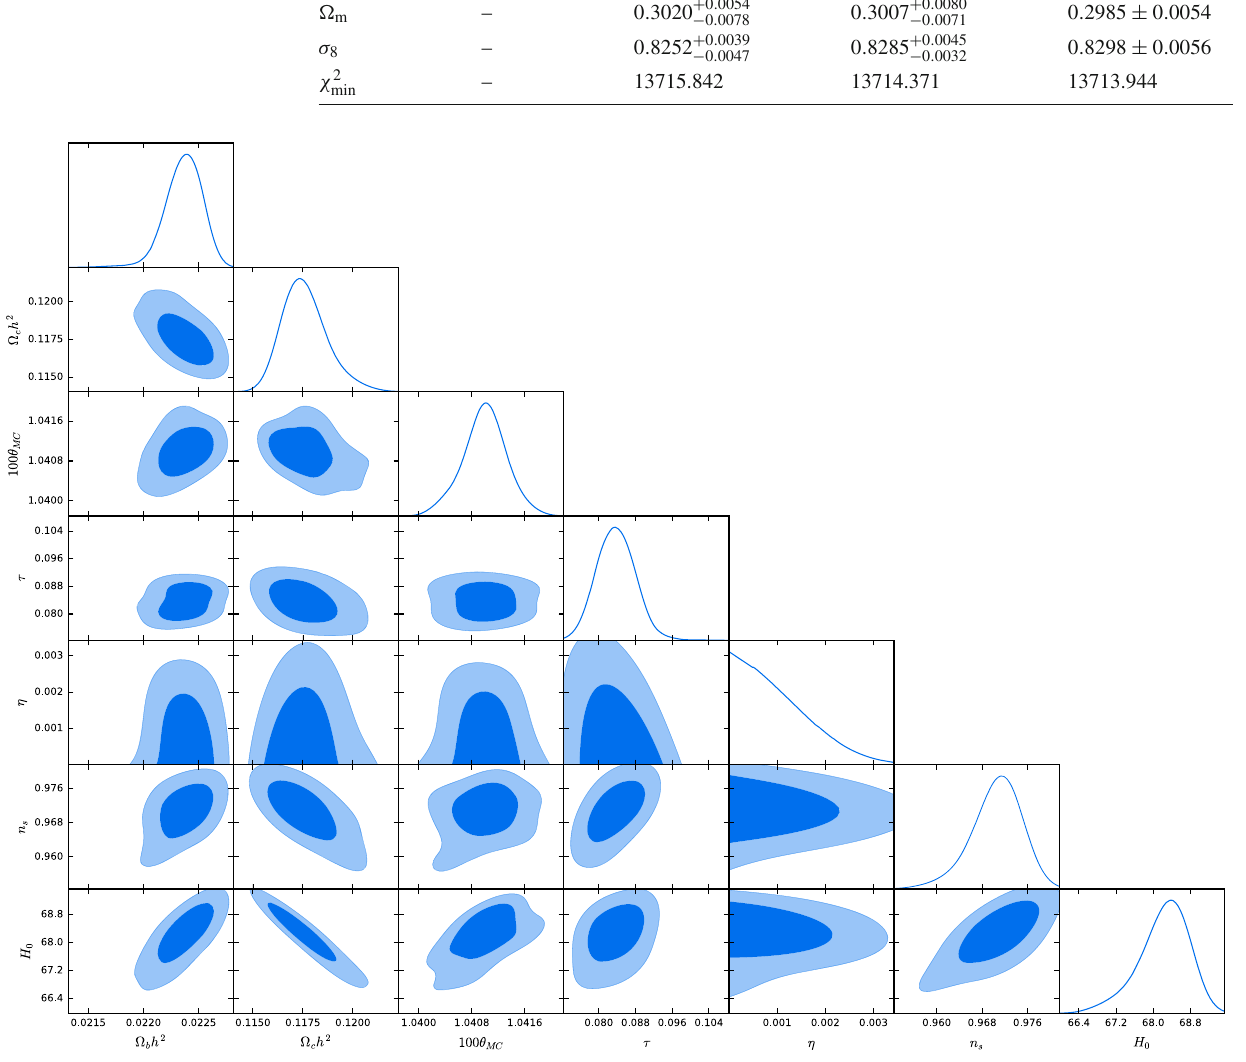
Fig. 5 The 1-dimensional posterior distributions on the individual parameters and 2-dimensional marginalized contours of the V (cid:4) DE model using the data combination